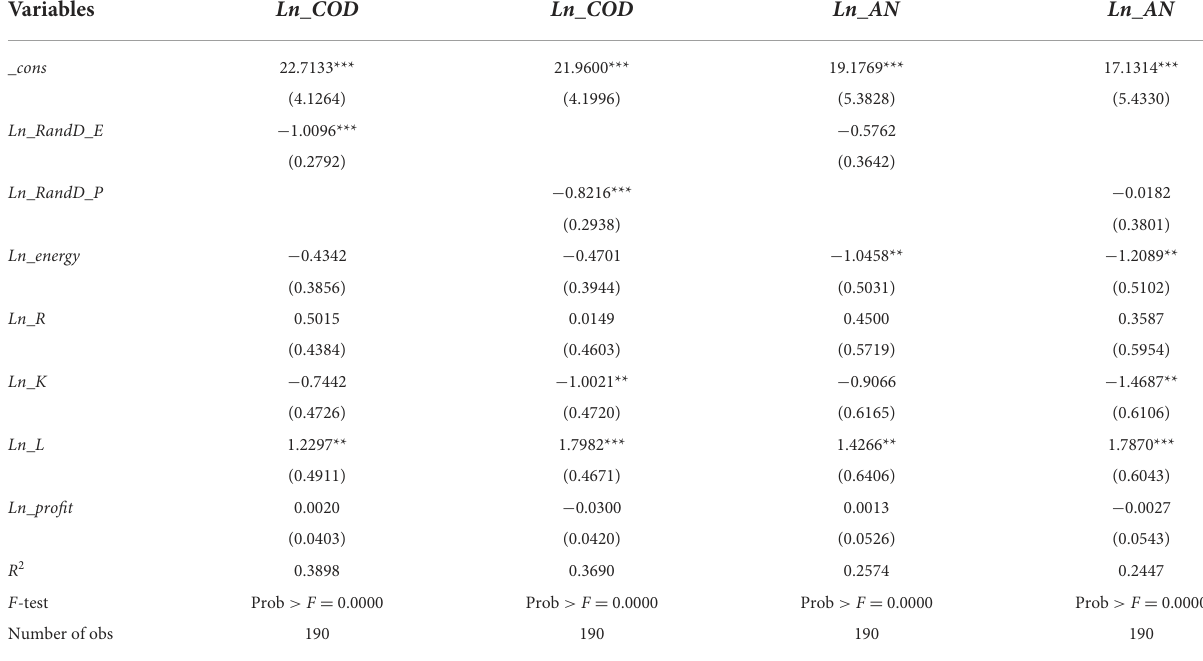
TABLE 2 Nexus between research and development (RandD) activities and industrial